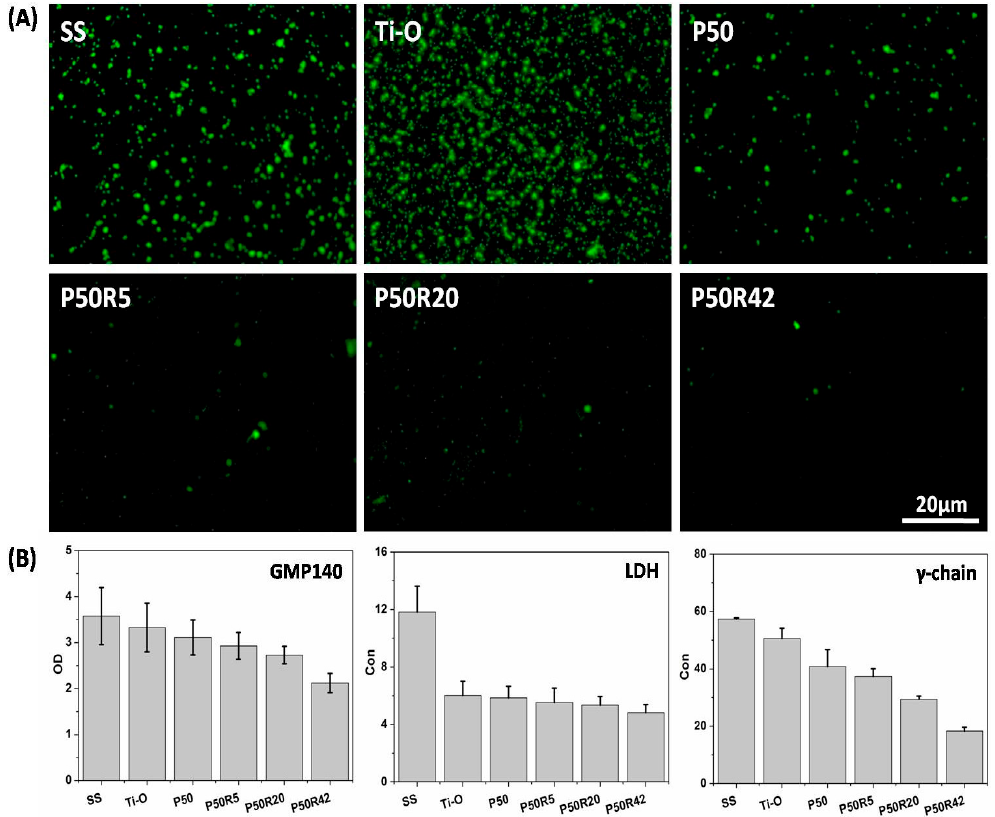
Figure 5. ( A ) P-selectin fluorescent images and ( B ) GMP140, LDH, γ -chain quantitative results of